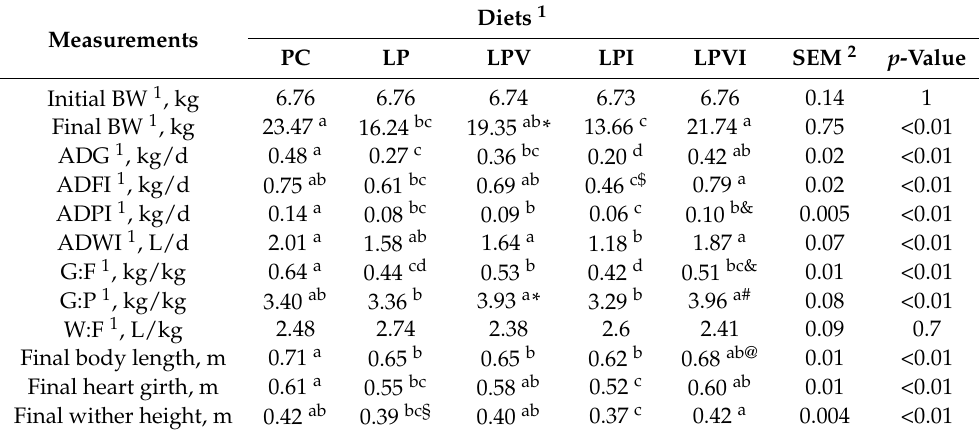
Final wither height, m 0.42 ab 0.39